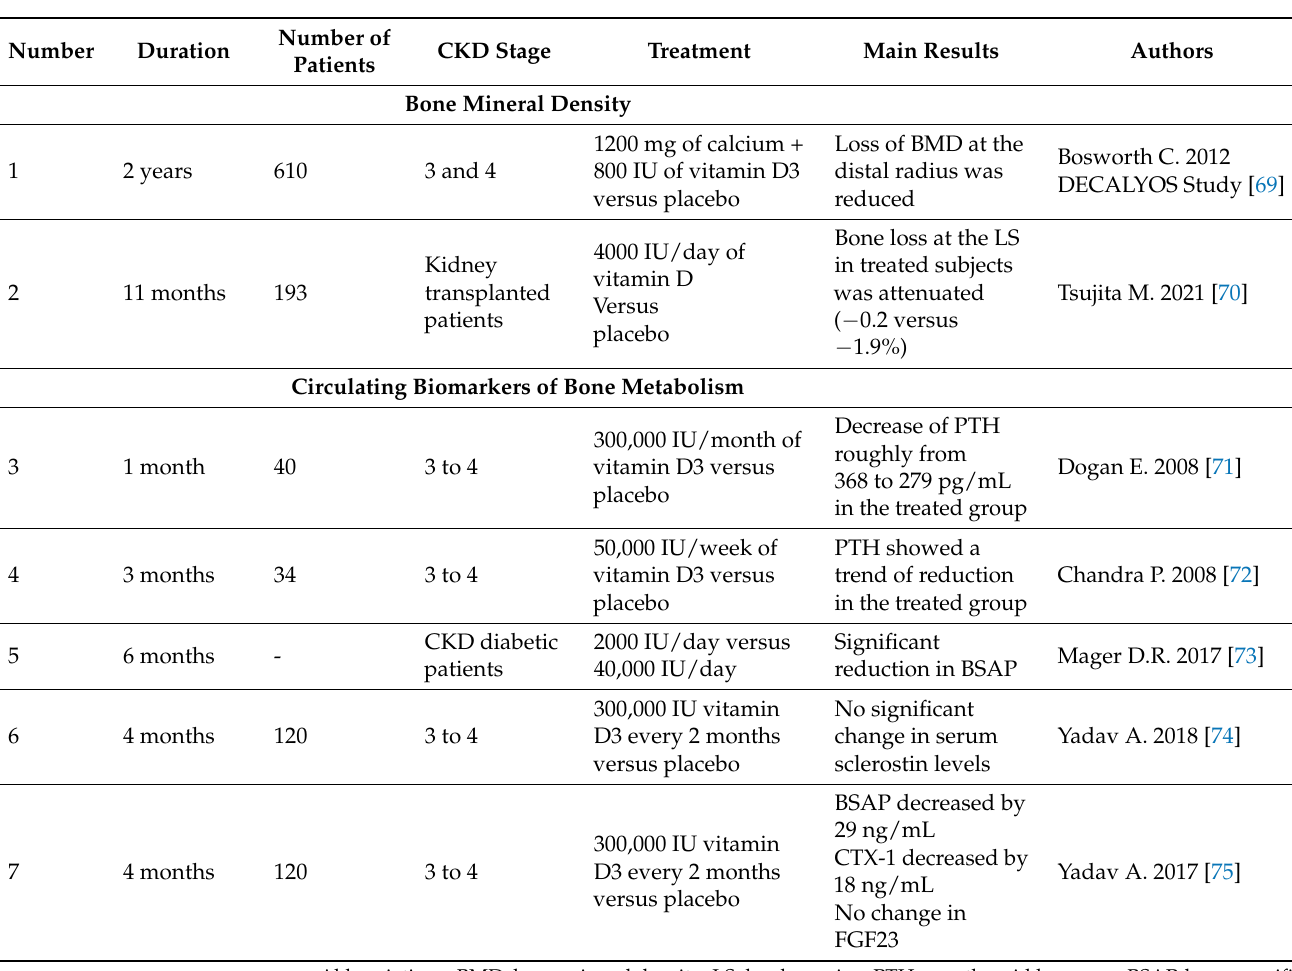
Table 1. Randomized clinical trials evaluating the effect of nutritional vitamin D supplementation on several mineral and bone metabolism parameters in patients with chronic kidney disease stage